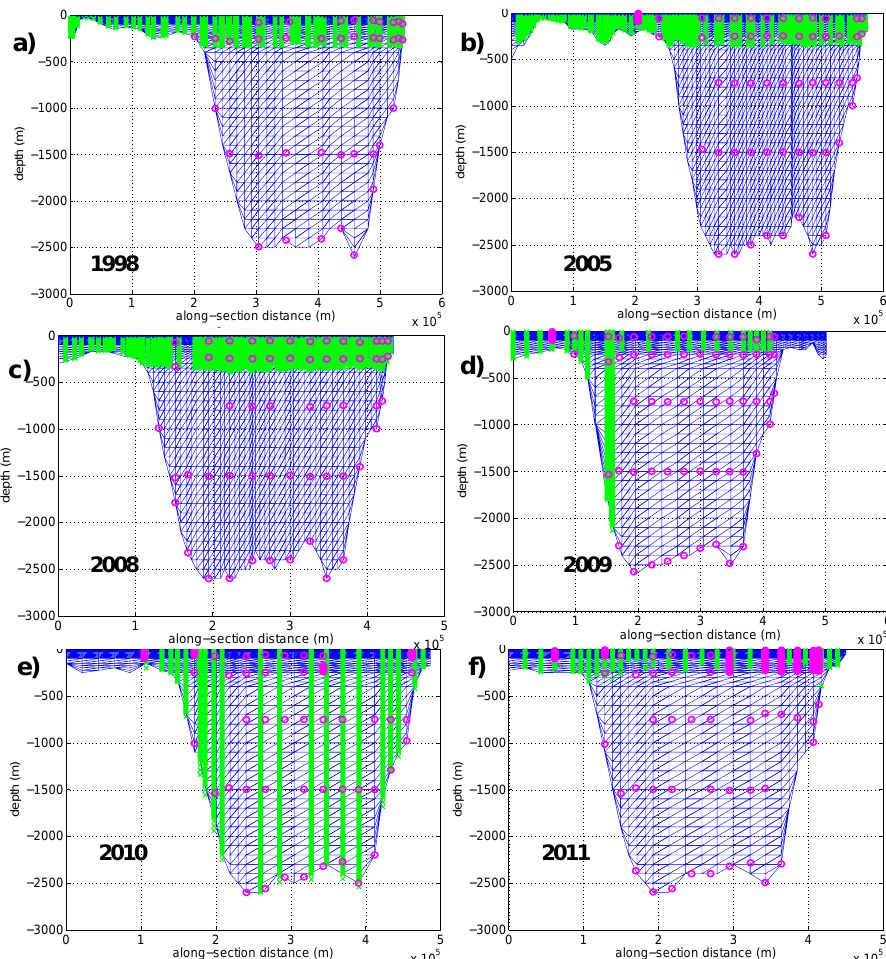
Fig. 7. FEMSECT grid used for the inverse solution of our hydrographic and velocity observations in each year: (a) 1998, (b) 2005, (c) 2008, (d) 2009 and (e) 2010. The grid nodes represent the CTD stations, subsampled in the vertical, the red circles the mooring-based velocities and the green crosses the shipboard